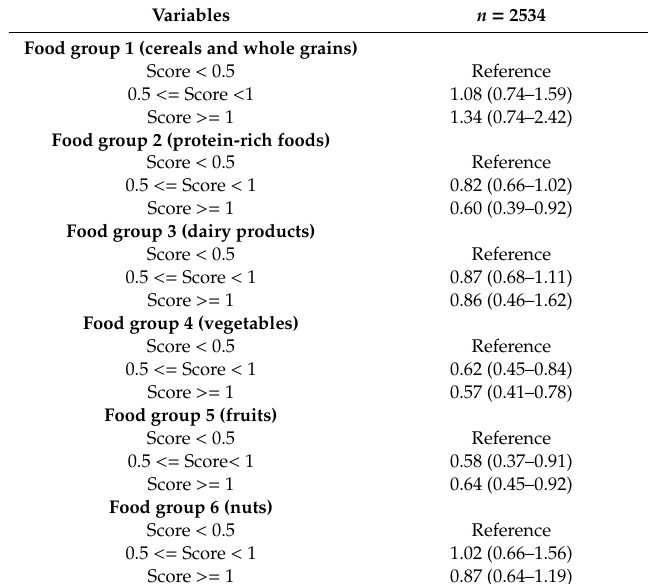
Table 4. Associations between the levels of adherence to individual food group index and the prevalence of metabolic